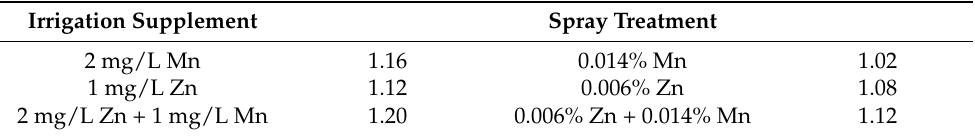
Table 4. Synergy factors (SF) of irrigation or spray treatments and foliar fungicides treatment at 94 days after